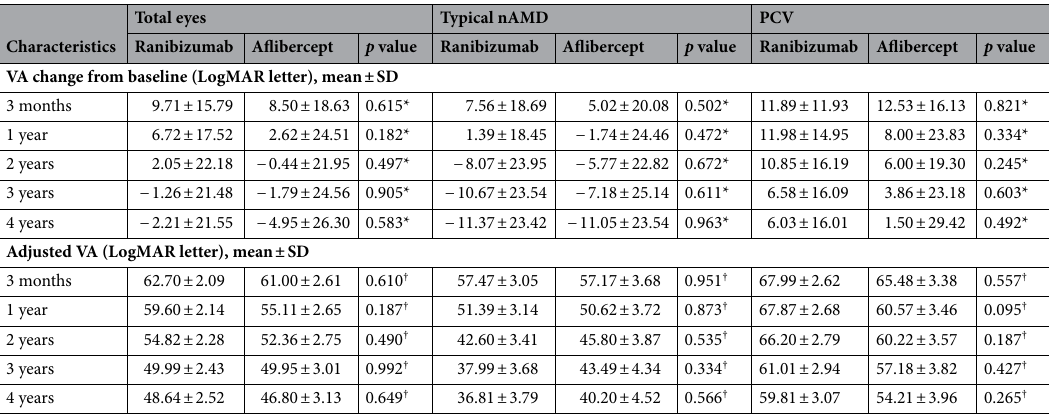
Table 2. Visual acuity changes from baseline and adjusted predictions of visual acuity by linear-mixed model. nAMD neovascular age-related macular degeneration, PCV polypoidal choroidal vasculopathy, VA visual acuity, LogMAR Log minimum angle of resolution. *Independent t-test. † Linear-mixed model.